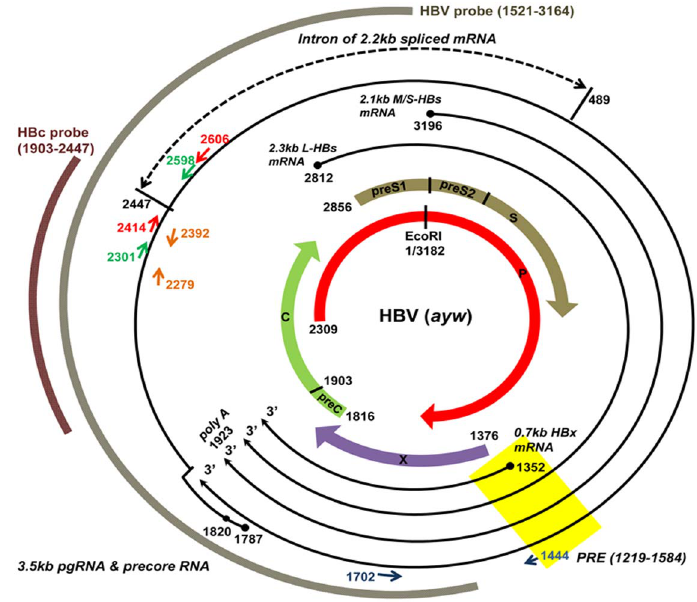
Figure 1. An HBV transcription map is illustrated. All HBV ( ayw ) transcripts are shown in solid lines, and a major intron of HBV pgRNA is shown in a dashed line (HBV: 2447–489). PCR primers used for detection of all species of HBV RNAs are shown in blue (HBV: 1444–1702), and primers used for non-spliced pgRNA are shown in red and green (HBV: 2414–2606, HBV: 2301–2598). PCR primers used for detection of HBV core + RNAs are shown in brown (HBV: 2279–2392). An HBV genome is known to encode a 3.5 kb precore specific RNA which is responsible for the production of precore and HBeAg proteins. This 3.5 kb precore transcript is longer than the 3.5 kb pgRNA by 25–30 nt at the 5 9 terminus [45]. The primer pairs HBV 2301–2598 and 2414–2606 cannot distinguish between the precore RNA and pgRNA. However, our HBV replicon system (plasmid pCHT-9/3091) does not produce the 3.5 kb precore RNA [30]. Core + RNAs refer to the 3.5 kb pgRNA, 3.5 kb precore RNA, and the 2.2 kb major spliced RNA. HBc probe (nt 1903–2447) in Northern blot analysis was specific for HBV core + RNAs. HBV probe (nt 1521–3164) was prepared for Southern blot analysis of viral replication. C: HBV core, preC: HBV precore, P: polymerase, preS1, preS2, and S: HBV envelope, X: HBx. PRE: posttranscriptional regulatory element